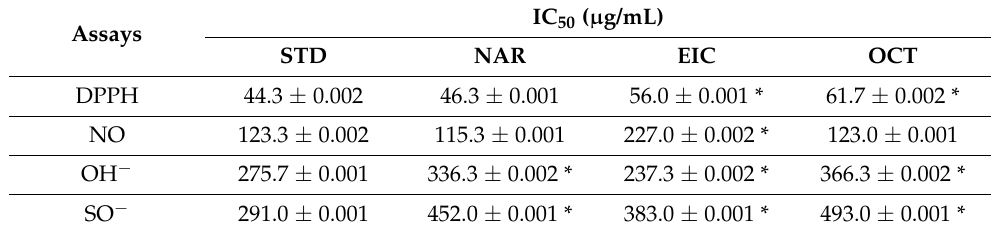
Table 1. IC 50 values of samples against ascorbic acid (standard). Assays